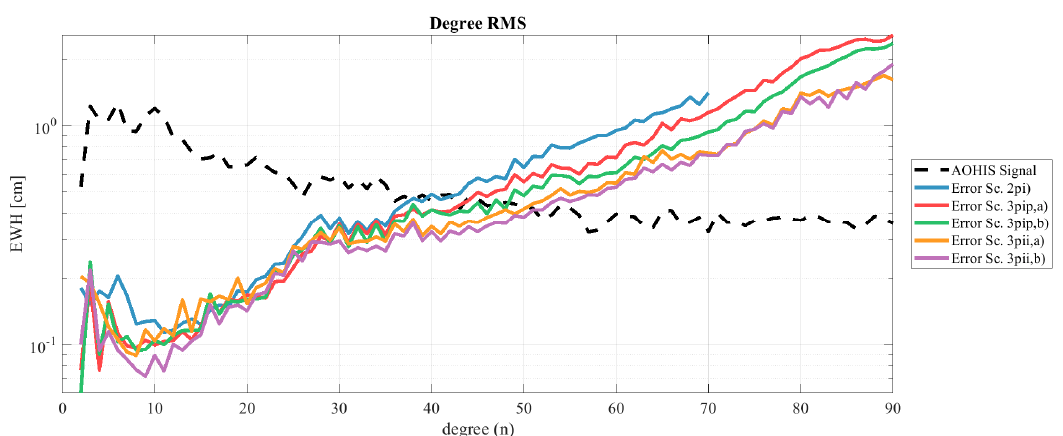
Figure 3. Degree root mean square (RMS) of double pair (estimated until d / o 70) vs. triple pair (estimated until d / o 90) scenarios of the whole solution. Daily Wiese solution estimated until d / o 15.